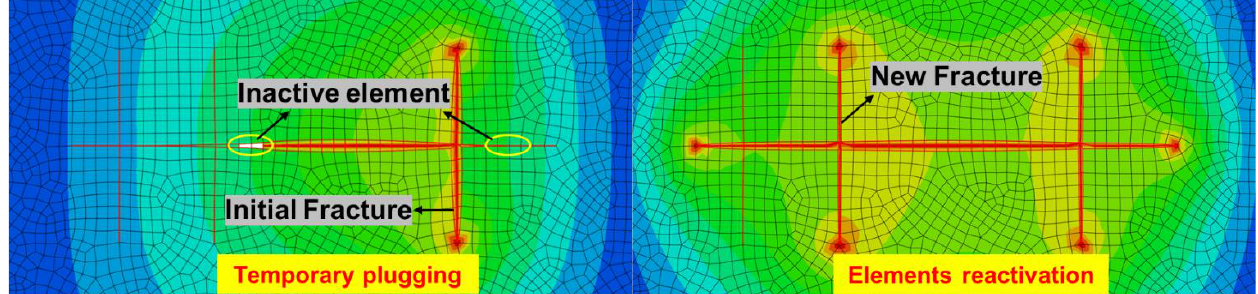
Figure 7. Schematic diagram of fracture temporary plugging simulation.